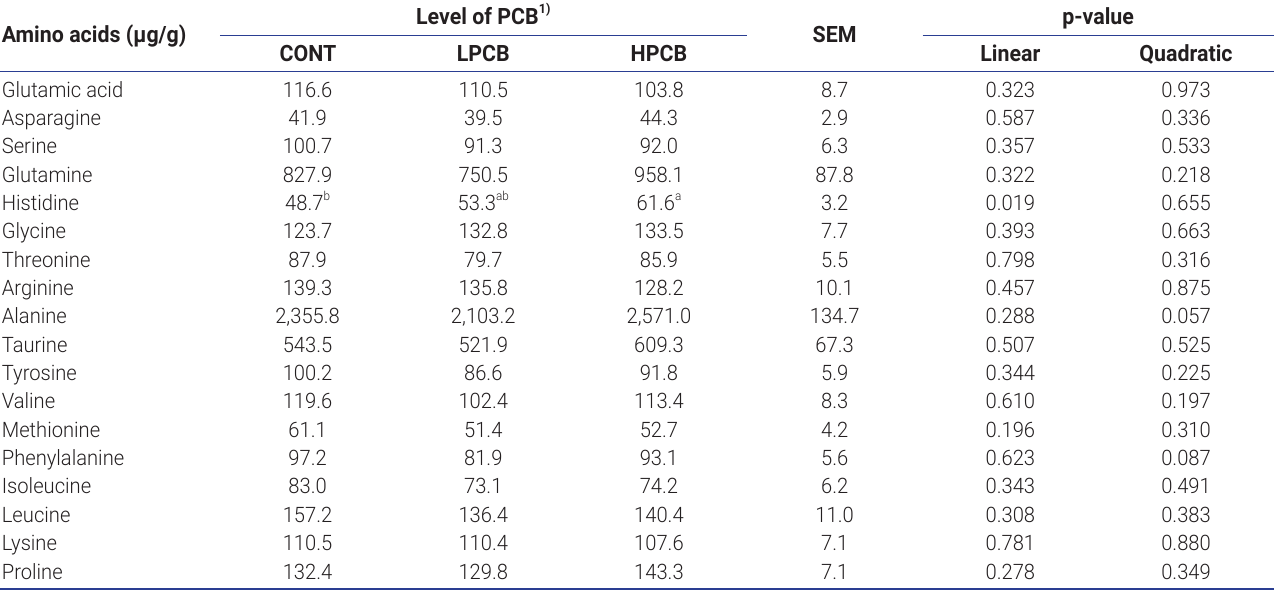
Table 8. Effects of pineapple cannery by-product on longissimus muscle free amino acid composition of growing-finishing Hanwoo steers Amino acids